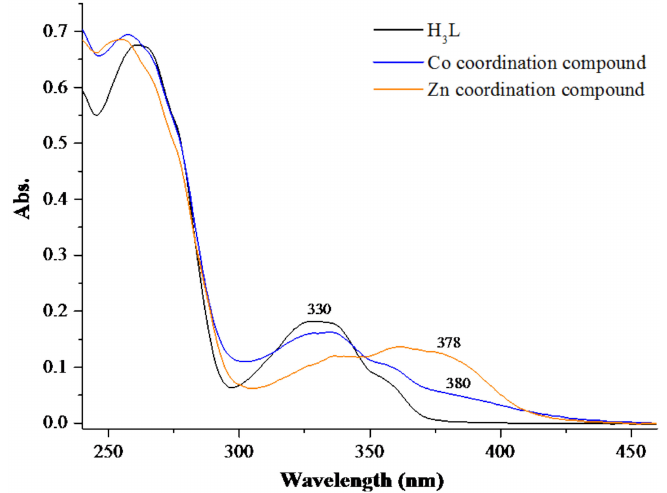
Figure 5. Ultraviolet–visible spectroscopy UV-Vis absorption spectra of H 3 L and its coordination compounds 1 and 2 in MeOH (1 × 10 − 5